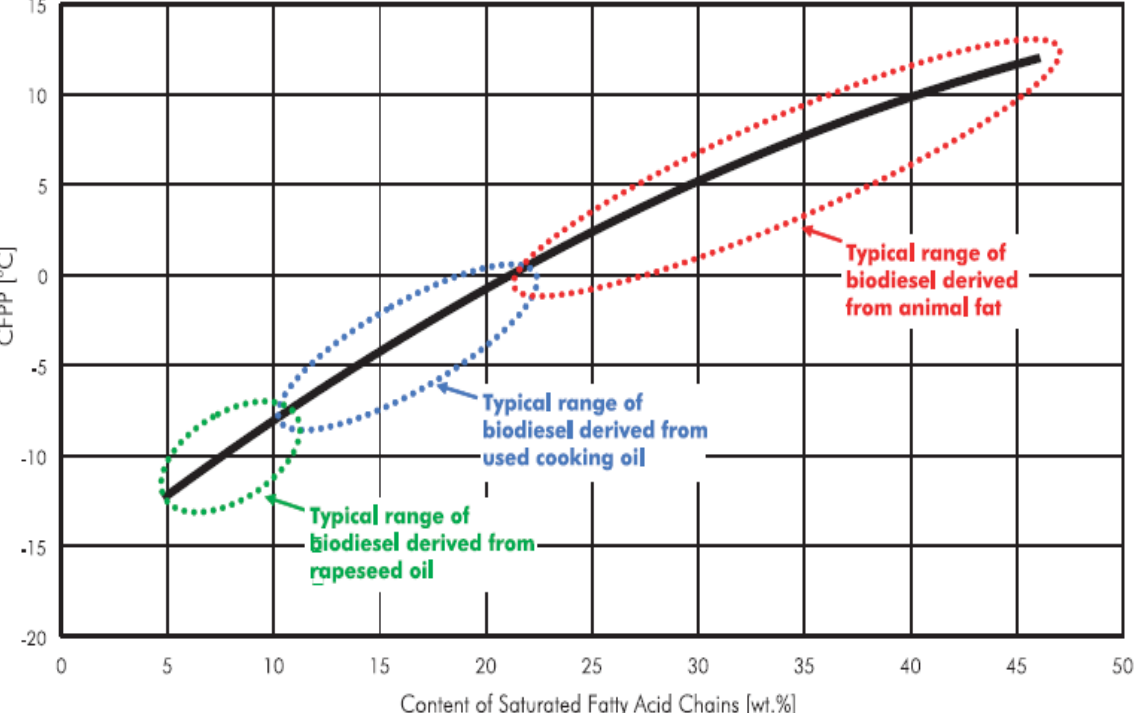
Figure 3. Relation between saturated fatty acid chain in biodiesel and its CFPP value